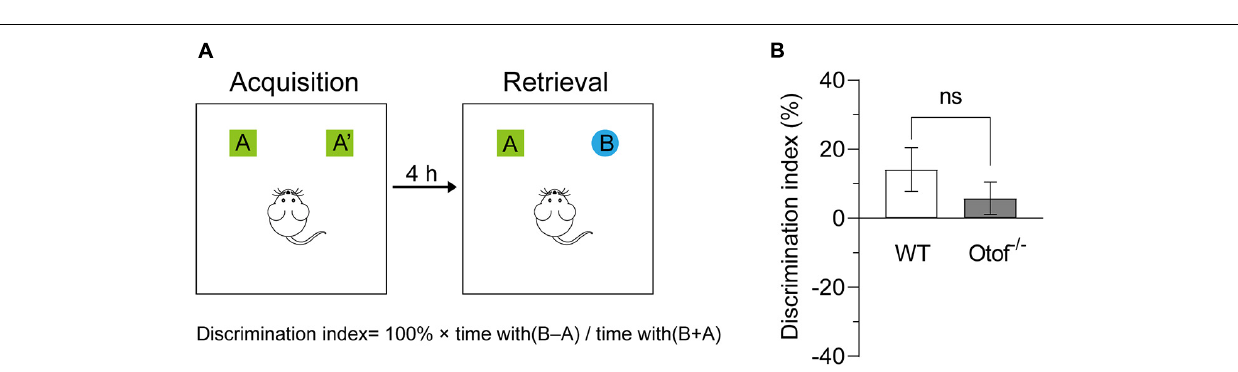
FIGURE 3 | Otof − / − mice showed impaired social memory in a three-chamber social interaction experiment at 6 months old. (A) WT and Otof − / − mice showed normal sociability in the social interaction test. (B) Representative tracks of WT and Otof − / − mice in the social interaction test. (C) Otof − / − mice showed impaired social memory in the social novelty test. (D) Representative tracks of WT and Otof − / − mice in the social novelty test. The starting point and the ending point of tracks in (B,D) were represented by a red dot and a green dot, respectively. All values are presented as mean ± SEM and analyzed by unpaired t -test for panels (A,C) . * p < 0.05, **** p < 0.0001 vs. WT. WT: n = 10; Otof − / − : n = 10. WT, wild-type mice; Otof − / − , otoferlin knockout mice; E, empty; S1, stranger 1; S2, stranger 2; ns, not significant.